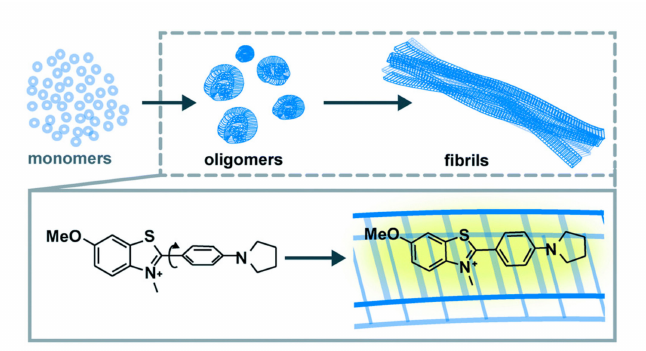
Figure 3. Pathway of amyloid fibril formation starting from monomeric proteins and the common cross- β sheet motif of amyloid fibrils to which benzothiazole salts bind. The binding of ThX to the fibrils restricts the rotation around the C—C bond resulting in a fluorescence turn-on response. Reprinted from Ref [11]—published by the Royal Society of Chemistry.